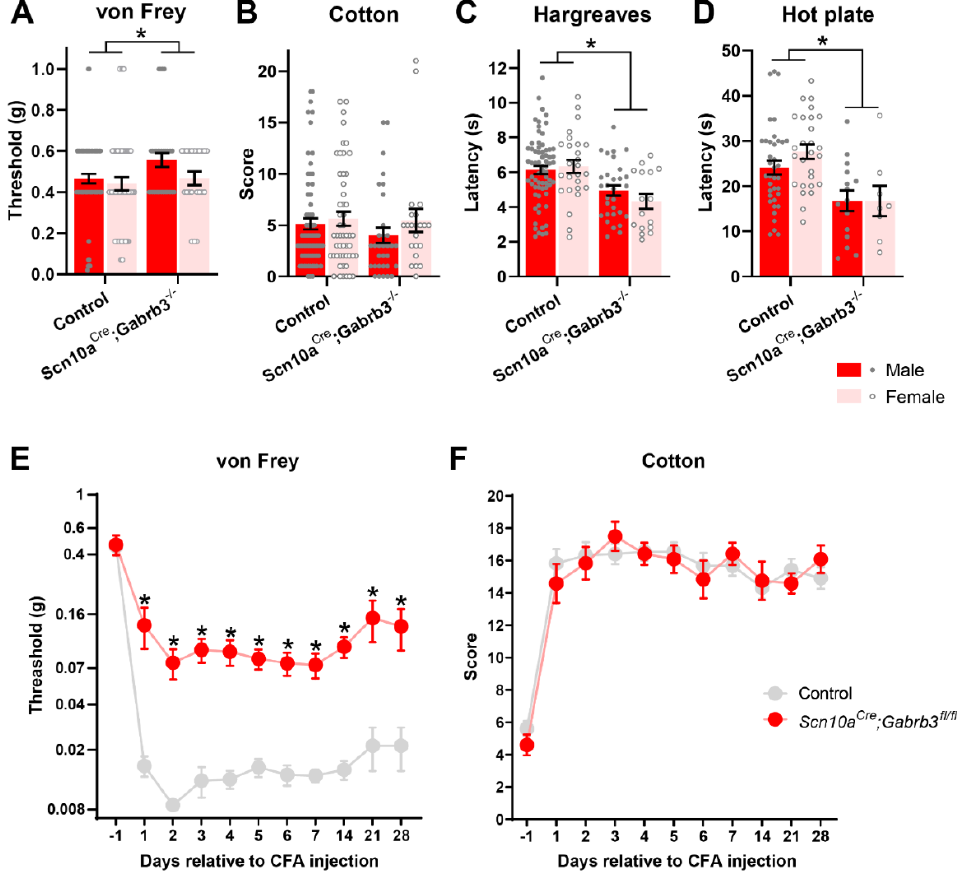
Figure 2. Basal sensitivity to punctate (von Frey, A ) but not dynamic (cotton, B ) mechanical stimuli is elevated in Scn10a Cre ; Gabrb3 fl/fl mice ( n = 32 male, n = 22 female; right bars, ( A ) relative to littermate controls ( n = 65 male, n = 52 female; left bars, A ). Male animals are shown as closed markers and red bars ( A – D ) and female as open markers and pink bars ( A – D ). For dynamic mechanical stimuli with cotton ( B ), no differences were evident between control ( n = 70 male, n = 52 female) and Scn10a Cre ; Gabrb3 fl/fl mice ( n = 33 male, n = 22 female). Heat pain threshold determined using the Hargreaves test ( C ) was lower in Scn10a Cre ; Gabrb3 fl/fl mice ( n = 30 male, n = 16 female) than in littermate controls ( n = 68 male, n = 52 female). Similarly, for the 50 °C hot plate test ( D ), heat pain threshold was lower in Scn10a Cre ; Gabrb3 fl/fl mice ( n = 15 male, n = 8 female) than in littermate controls ( n = 37 male, n = 27 female). In the days following CFA injection into the hindpaw, a pronounced decrease in withdrawal threshold to punctate (von Frey, E ) mechanical stimulation was observed in littermate controls (grey, E , n = 12) but not in Scn10a Cre ; Gabrb3 fl/fl mice (red, E , n = 22). In contrast, control ( n = 12) and Scn10a Cre ; Gabrb3 fl/fl mice ( n = 22) both developed an increased response score to dynamic (cotton, F ) mechanical stimulation in the four-week period following CFA injection. Values of p < 0.05 were considered significant and are indicated with asterisks as follows; * p < 0.05.